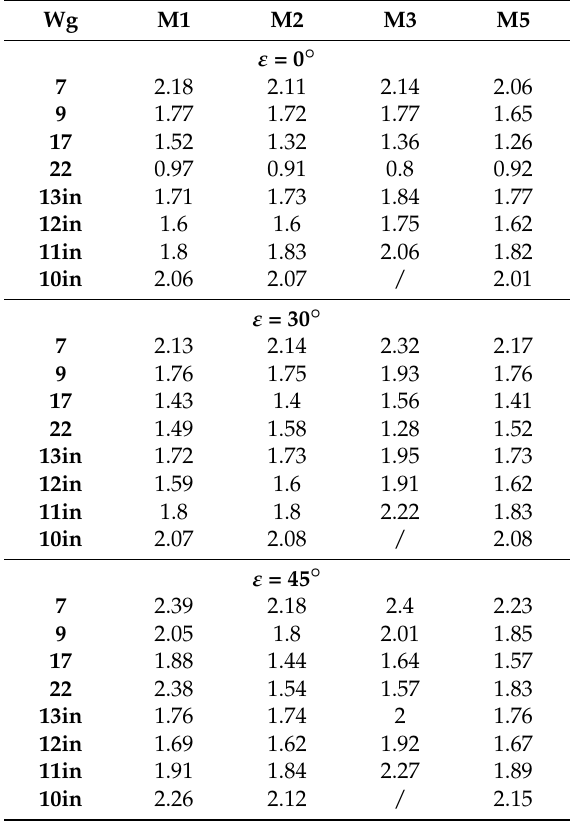
Table 7. Thee p 250 values inside the reservoir and on the crown wall (kPa), for ε = 0 ◦ (no parapet), ε = 30 ◦ and ε = 45 ◦ . The positions of the water gauges (WG) are shown in Figure 4. Wg M1 M2